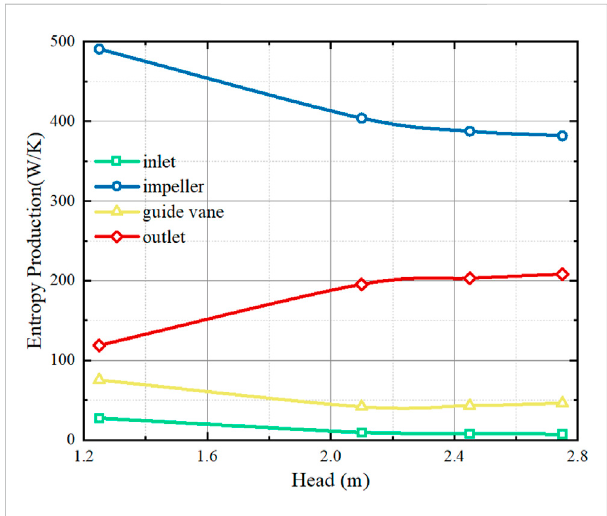
FIGURE 10 Total entropy production under different working conditions.